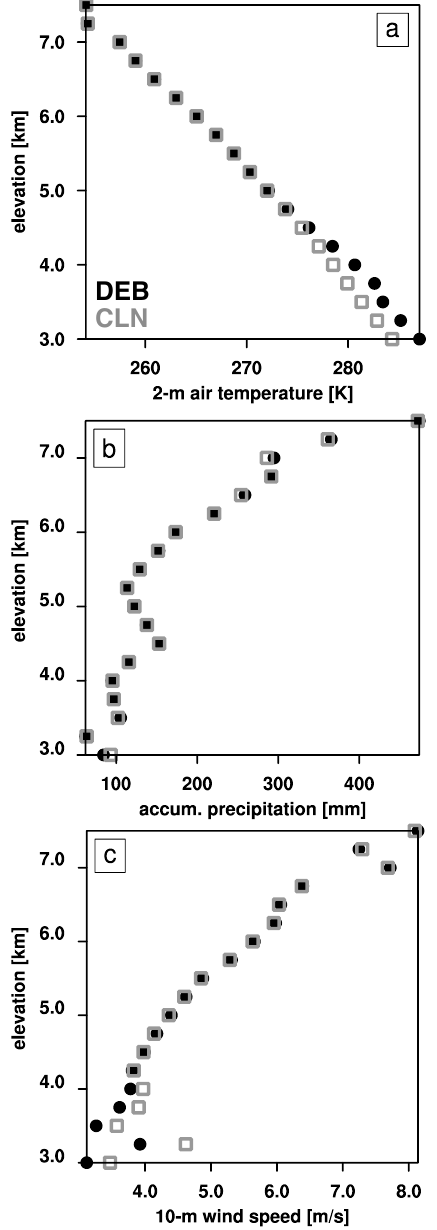
Figure 10. Elevational profiles of near-surface (a) air tempera- ture [K] and (b) accumulated precipitation [mmw . e . ], and (c) wind speed at a height of 10m [ms − 1 ], from the DEB (black circle mark- ers) and CLN (gray squares) simulations between 1 July and 15 September 2004.